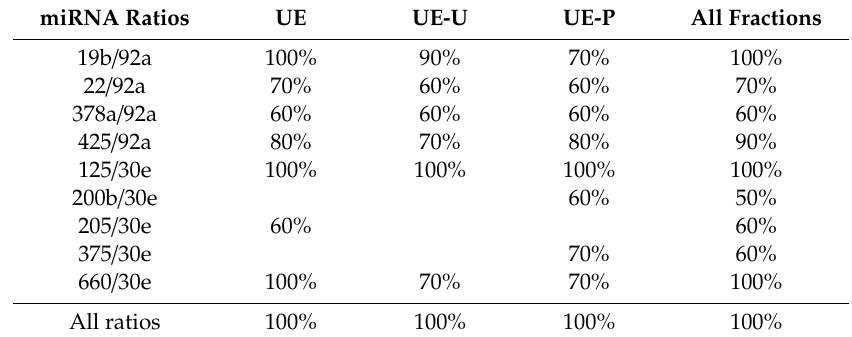
Table 7. Definitely PCa. The percentage of PCa patients divided from the control group (HD + BPH). miRNA